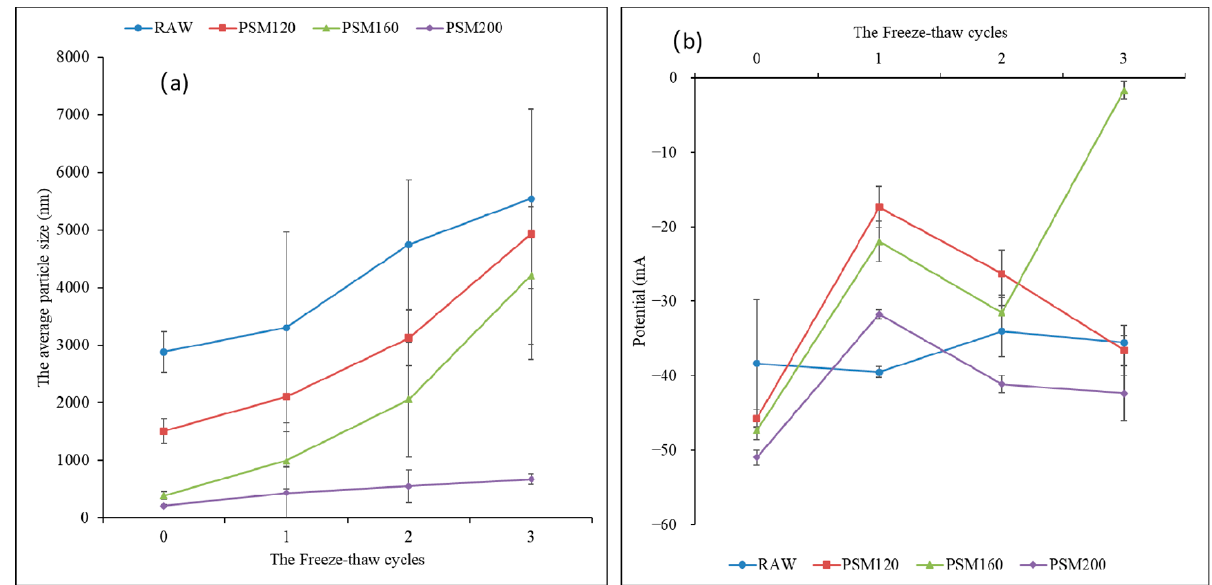
Figure 8. ( a ) Effect of freeze–thaw cycles on average particle size of PSMs. ( b ) Effect of freeze–thaw cycles on ζ -potential of PSMs. RAW: raw pumpkin seeds, PSM120: pumpkin seeds roasted at 120 °C, PSM160: pumpkin seeds roasted at 160 °C, and PSM200: pumpkin seeds roasted at 200 °C. Different lowercase letters represent the significant difference of ζ -potential of different pumpkin seed milks at the same salt concentration, and different uppercase letters represent the significant difference of ζ -potential of the same milk at different salt concentrations.